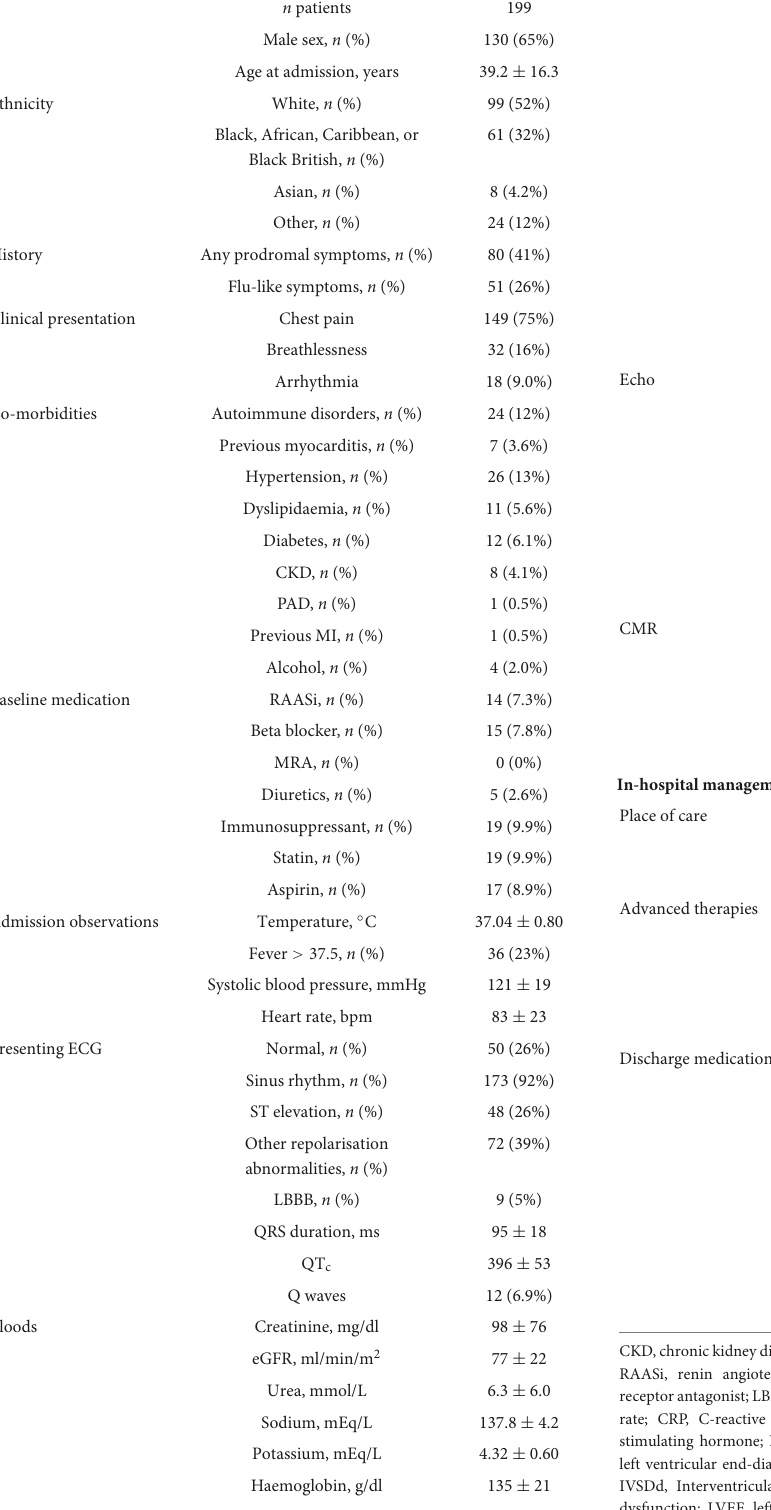
rate; CRP, C-reactive protein; ESR, erythrocyte sedimentation rate; TSH, thyroid stimulating hormone; NT-proBNP, N-terminal pro-brain natriuretic peptide; LVEDD, left ventricular end-diastolic dimension; LVEDV, left ventricular end diastolic volume; IVSDd, Interventricular septal diameter in diastole; LVSD, left ventricular systolic dysfunction; LVEF, left ventricular ejection fraction; LV, left ventricle; RVEDV, right